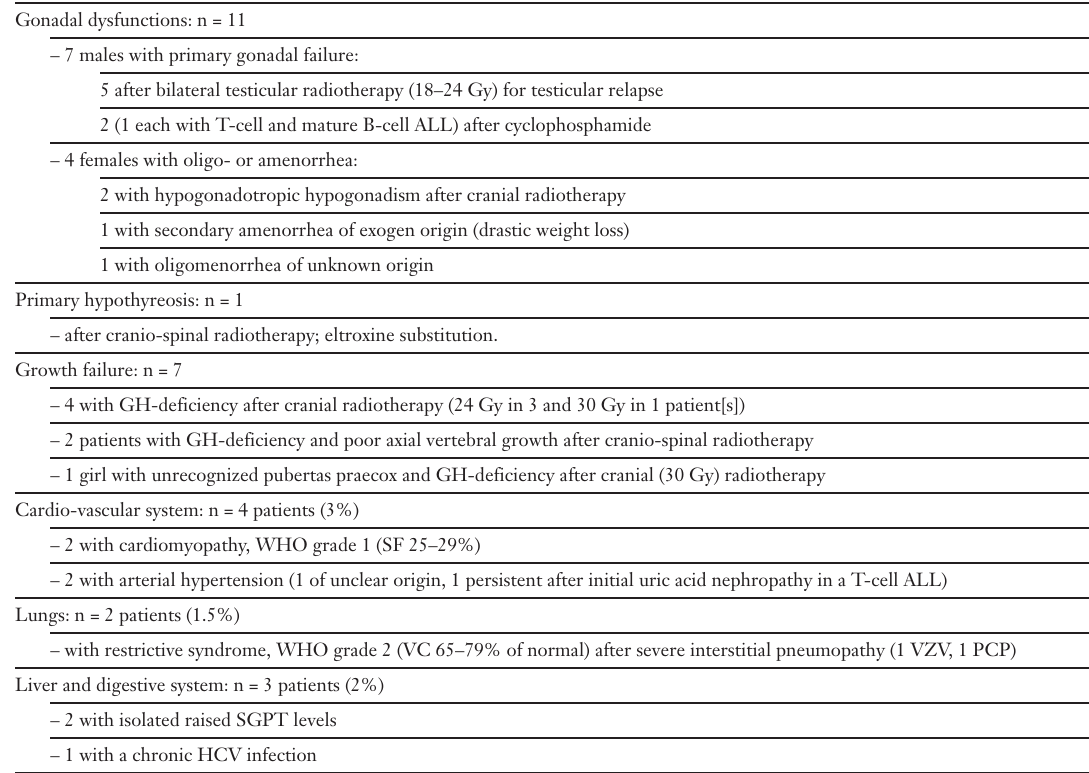
Somatic late effects (n = 140 patients assessed).